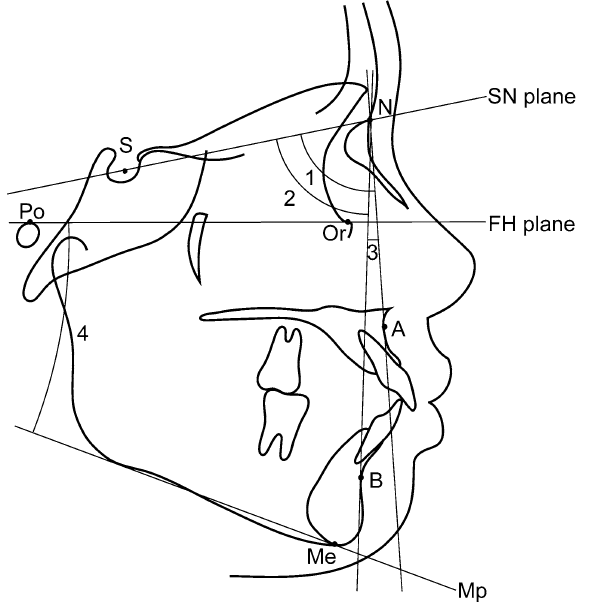
Figure 2. Lateral cephalometric analysis. 1, SNA angle (angle between the SN plane and NA line); 2, SNB angle (angle between the SN plane and NB line); 3, ANB angle (angle between the NA line and NB line); 4, Mandibular plane (Mp)—FH angle (angle between Mp and FH plane).